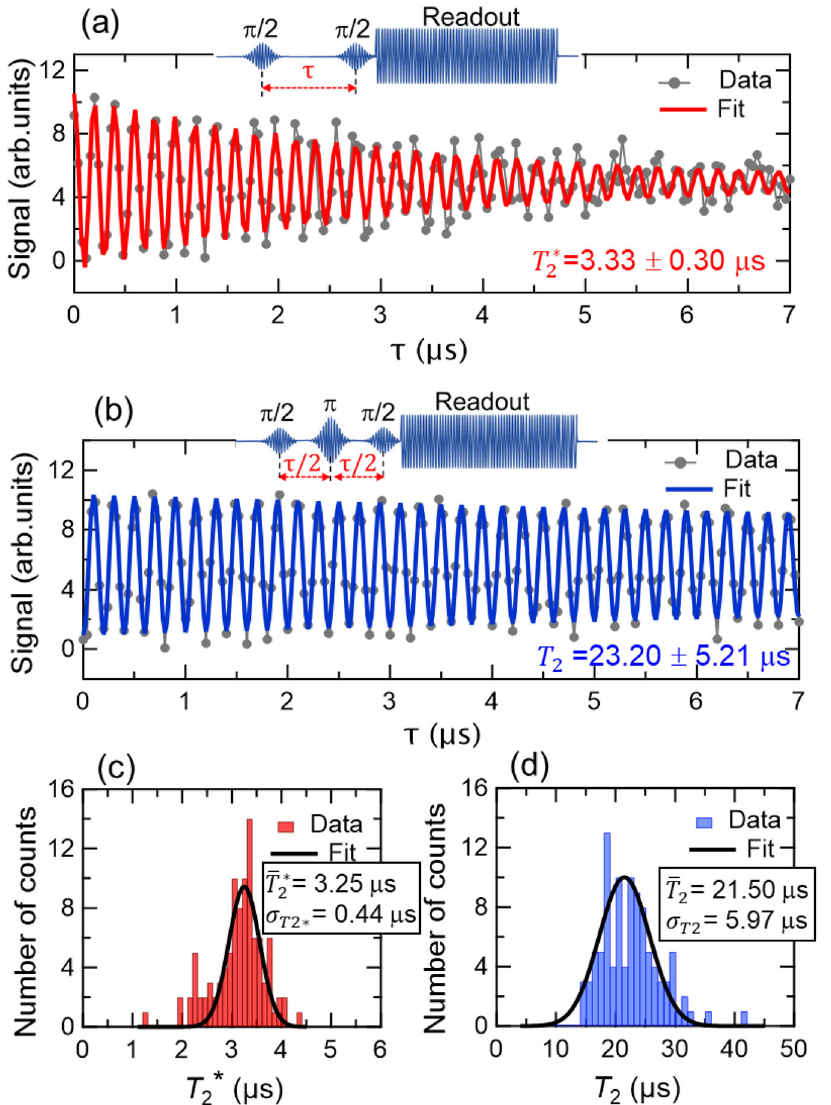
Fig. 4 Phase relaxation times: T (cid:6) from Ramsey measurement and T 2 from spin-echo experiment. Time-domain measurements showing a Ramsey fringe 2 ¼ 3 : 33 ± 0 : 30 μ s and b Hahn echo signal with T ¼ 23 : 20 ± 5 : 21 μ s. The pulse sequences for the measurements are shown in the insets. The signal with T (cid:6) 2 2 pulse sequences include a π pulse with a 40 ns duration, π = 2 pulses with same duration but half the amplitude of the π pulses, and readout pulses with 400 ns duration. Here the driving frequency in both measurements is detuned by 5 MHz from the qubit frequency and each coherence time is determined by fi tting with an exponentially decaying sinusoidal function. Statistical distributions of c the T (cid:6) values and d the T 2 values with Gaussian fi ts (solid 2